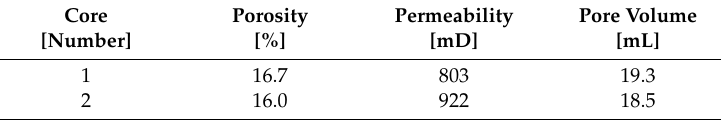
Table 2. Physical properties of Berea sandstone